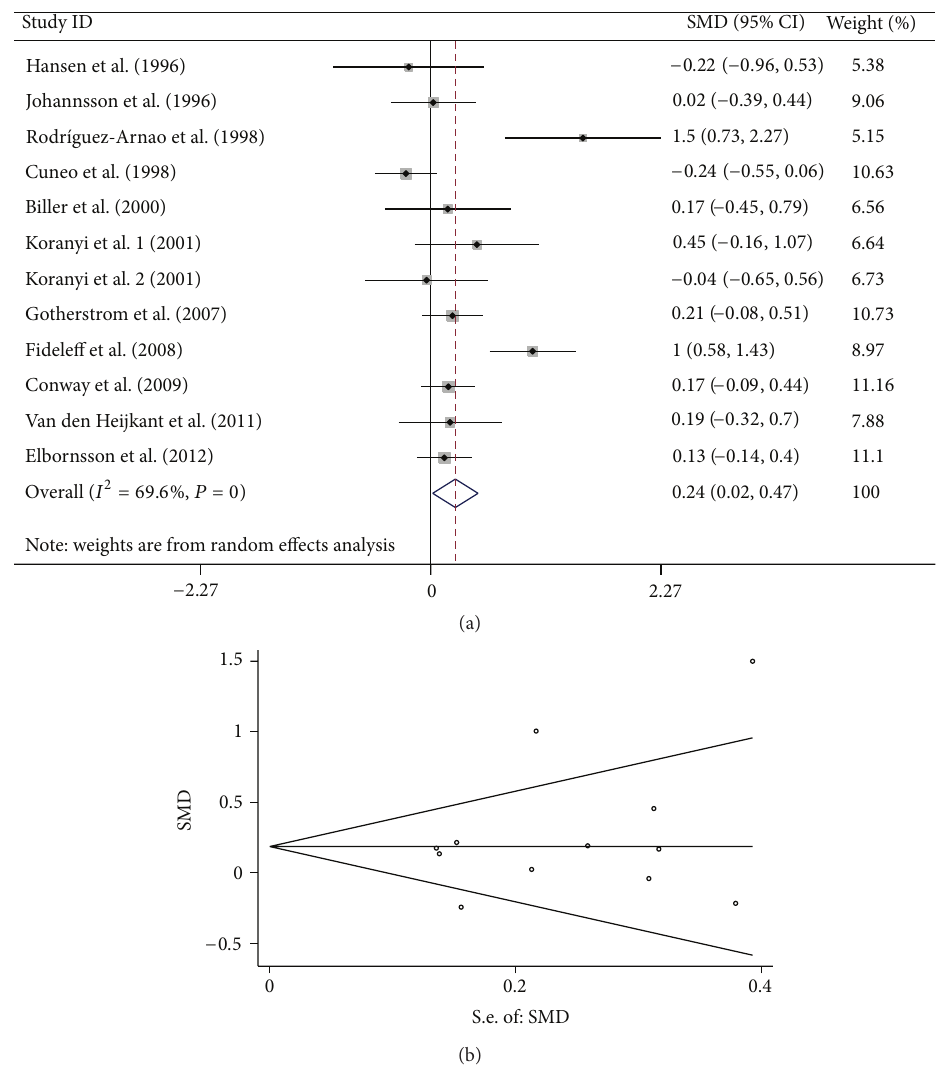
Figure 3: Forest plot and funnel plot for the association between GH treatment and BMD of TB. (a) Forest plot using a random effects model. (b) Funnel plot using Begg